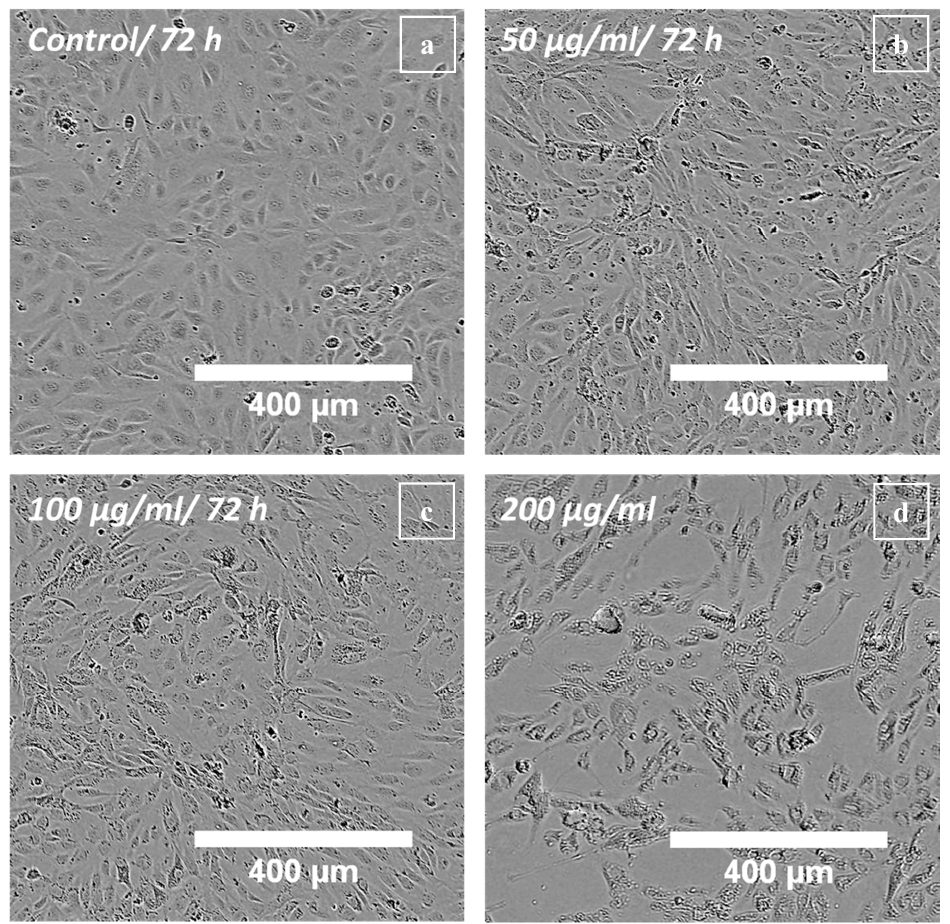
Figure 4. Live-cell microscopy of HUVECs treated with polyR-Fe 3 O 4 : Phase contrast images of HUVECs were taken after 72 h post particle addition. ( a ) Untreated control HUVECs, ( b ) HUVECs treated with 50 µg mL − 1 , ( c ) HUVECs treated with 100 µg mL − 1 and ( d ) HUVECs treated with 200 µg mL − 1 polyR-Fe 3 O 4 . Representative images of n = 3 experiments and hexaplicate samples are shown.